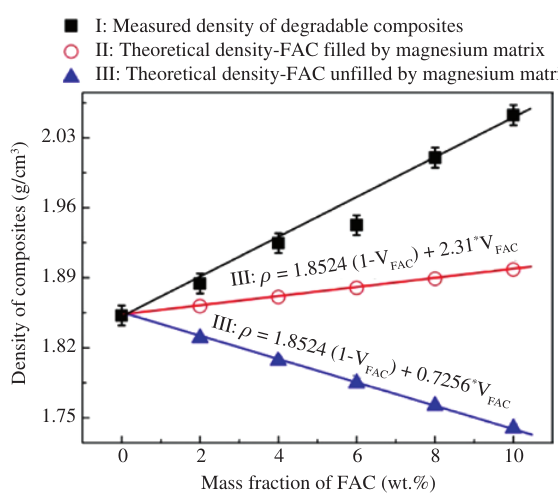
Figure 4: Theoretical and measured density values of the compos- ites versus FAC mass